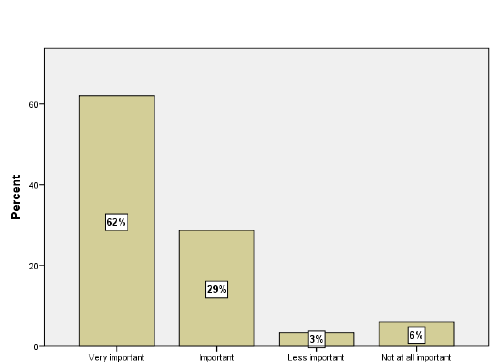
Figure 7: Bar chart showing percentage of respondents’ opinion about what they think about the using of social media to support the classroom